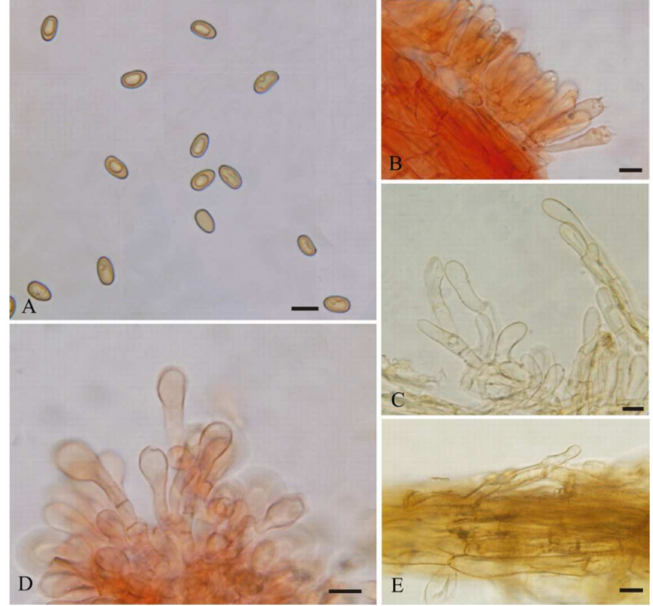
Figure 5. Mallocybe picea (BJTC FM555) ( A ) Basidiospores, ( B ) Basidia, ( C ) Caulocystidia, ( D ) Cheilo- cystidia, ( E ) Pileipellis. Scale bars: ( A – E ) = 10 µ